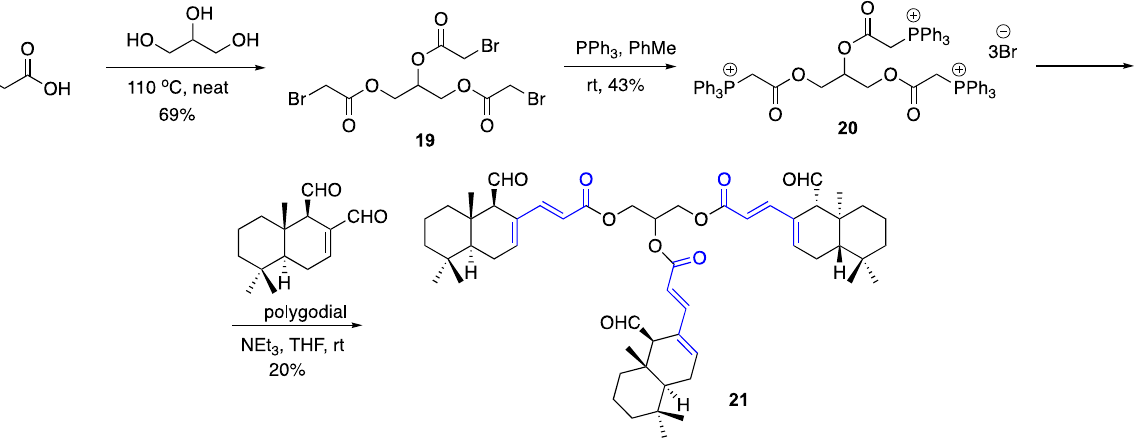
Figure 5. Synthesis of trimeric polygodial-based crosslinking agent 21 .